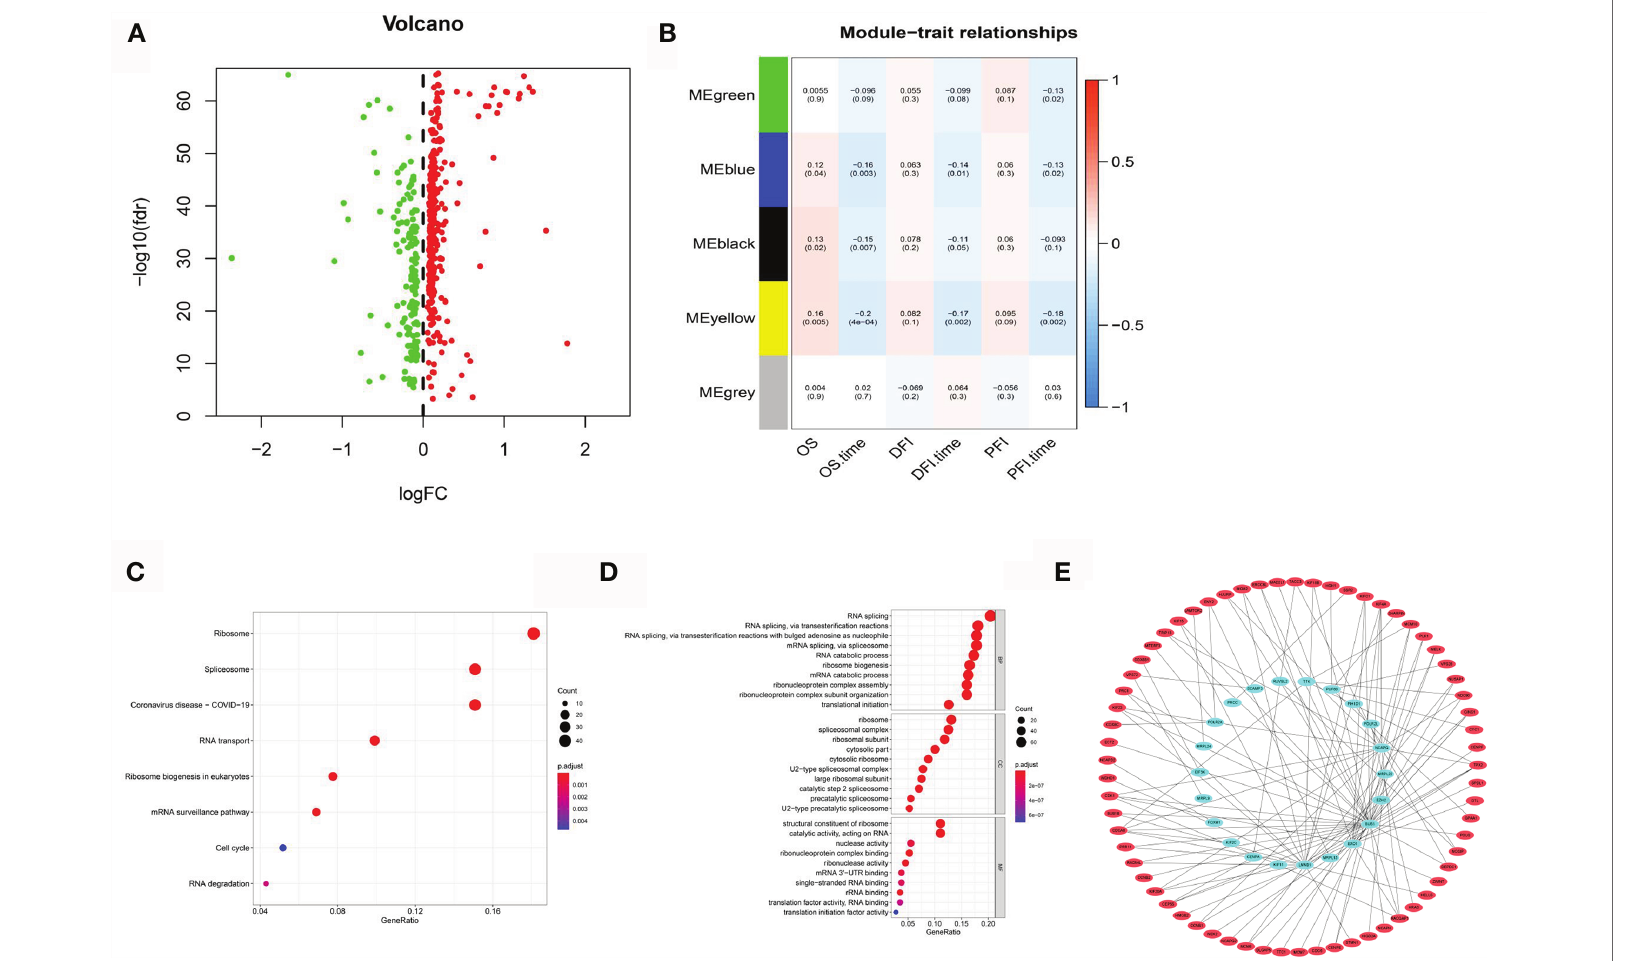
FIGURE 2 | Systematic analysis of epigenetic-related genes. (A) Volcano maps for 492 differentially expressed ERGs based on the GTEX-TCGA data set. (B) WGCNA analyzed the 492 ERGs combined with TCGA clinical information. (C) KEGG analysis of 410 hub ERGs. (D) GO analysis of 410 hub ERGs. (E) The apparent regulatory network based on a correlation coef fi cient greater than